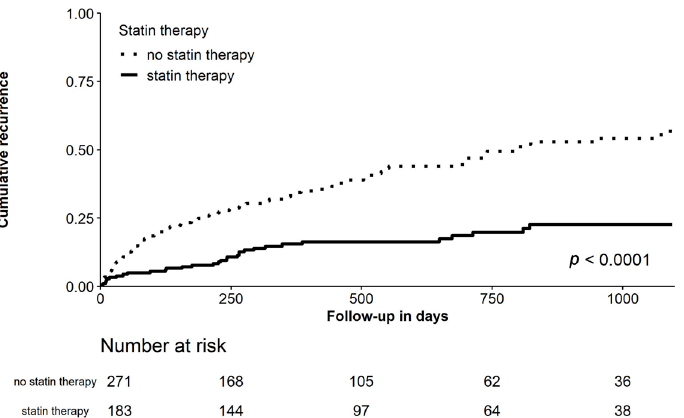
Figure 1. Cumulative incidence curve for recurrence of atrial fibrillation after CV comparing all patients with and without statins, with the log-rank test.